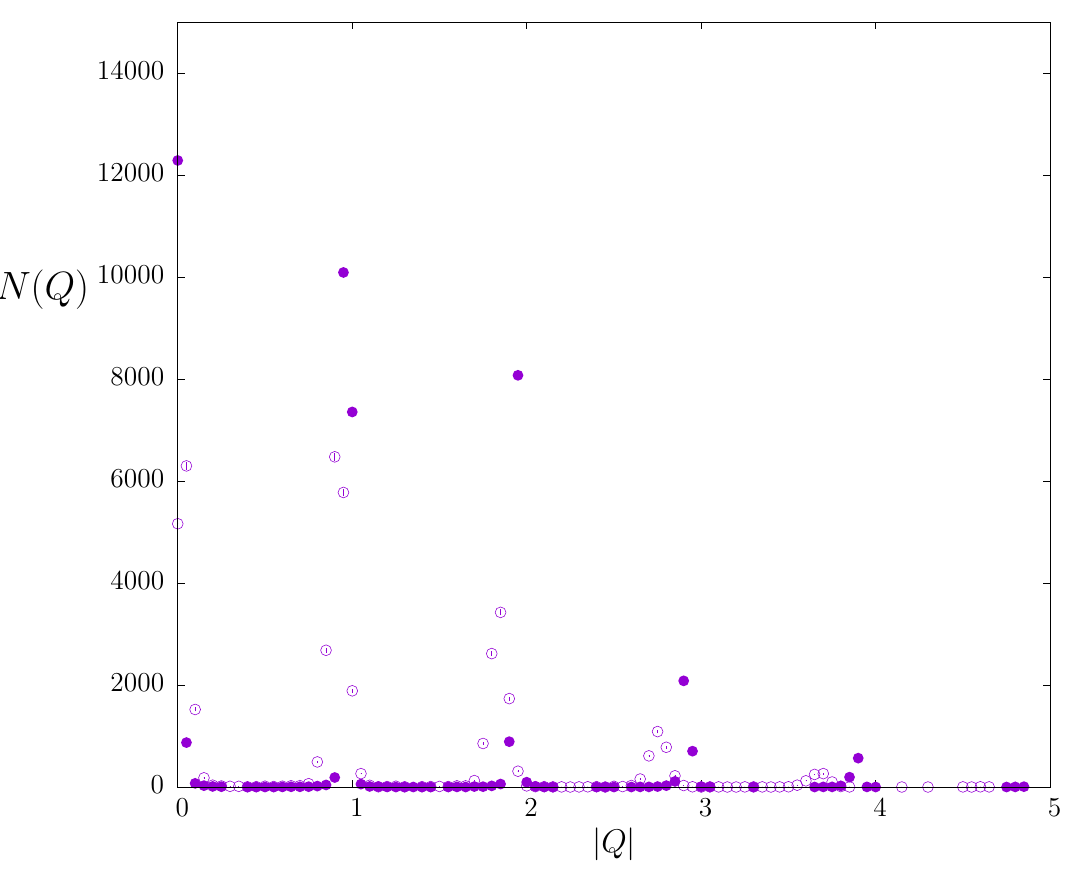
Figure 27 . Histogram of lattice Q after 4 cooling sweeps, ◦ , and after 20 cooling sweeps, • . From 40000 measurements at β = 6 . 50 on a 26 3 38 lattice. Points corresponding to N ( Q ) = 0 are